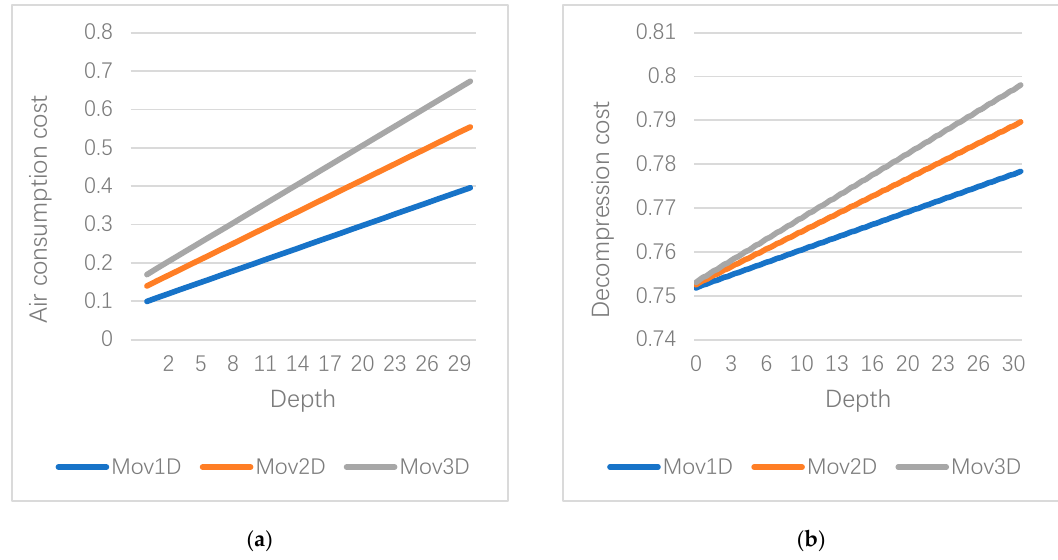
Figure 9. The evolution of the air consumption cost ( a ) and the decompression cost ( b ) with the increasing of the depth.